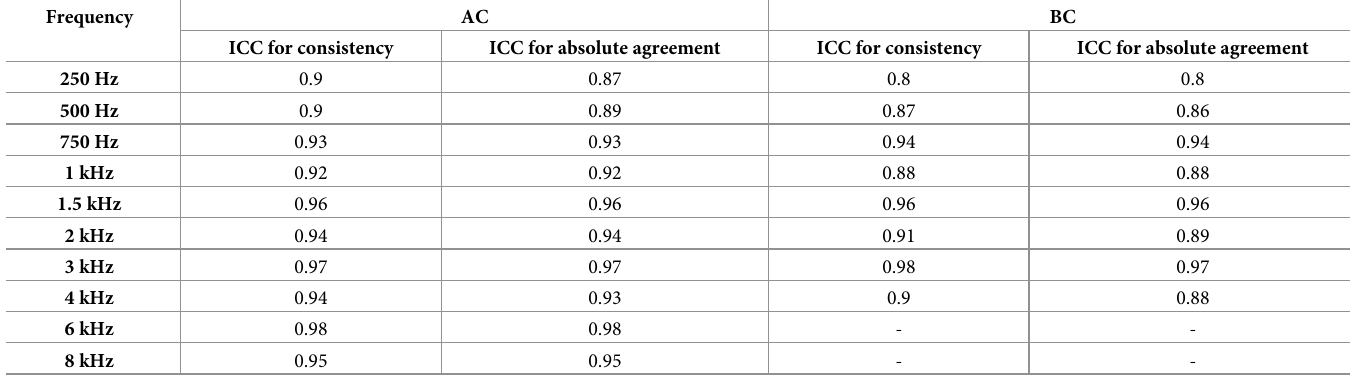
Table 3. Intraclass correlation coefficient for air conduction thresholds between HARP Inventis and HEARZAP audiometer (consistency and absolute agreement). Frequency